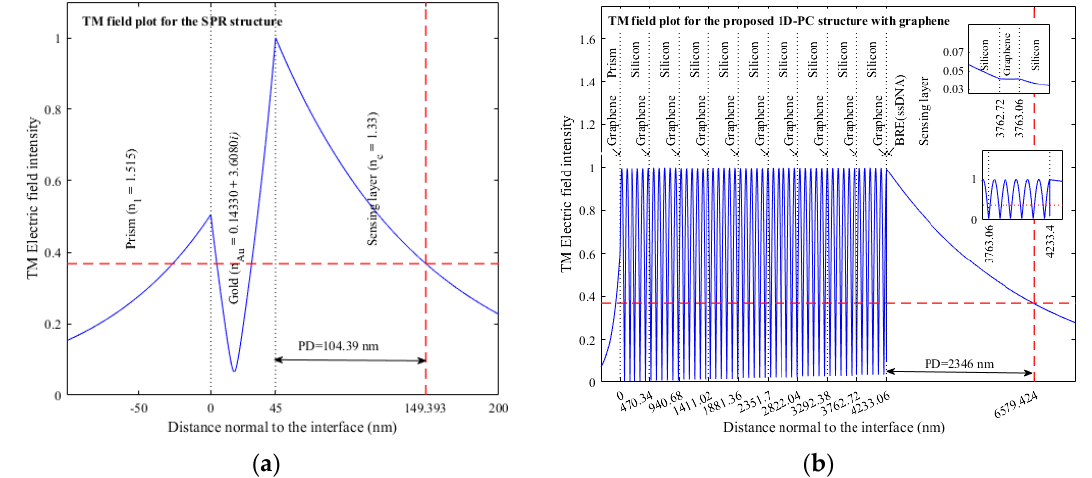
Figure 4. Electric field distribution along the distance normal to the stacking of layers for p-polarized light for ( a ) Simple SPR, ( b ) 1DPC [7].